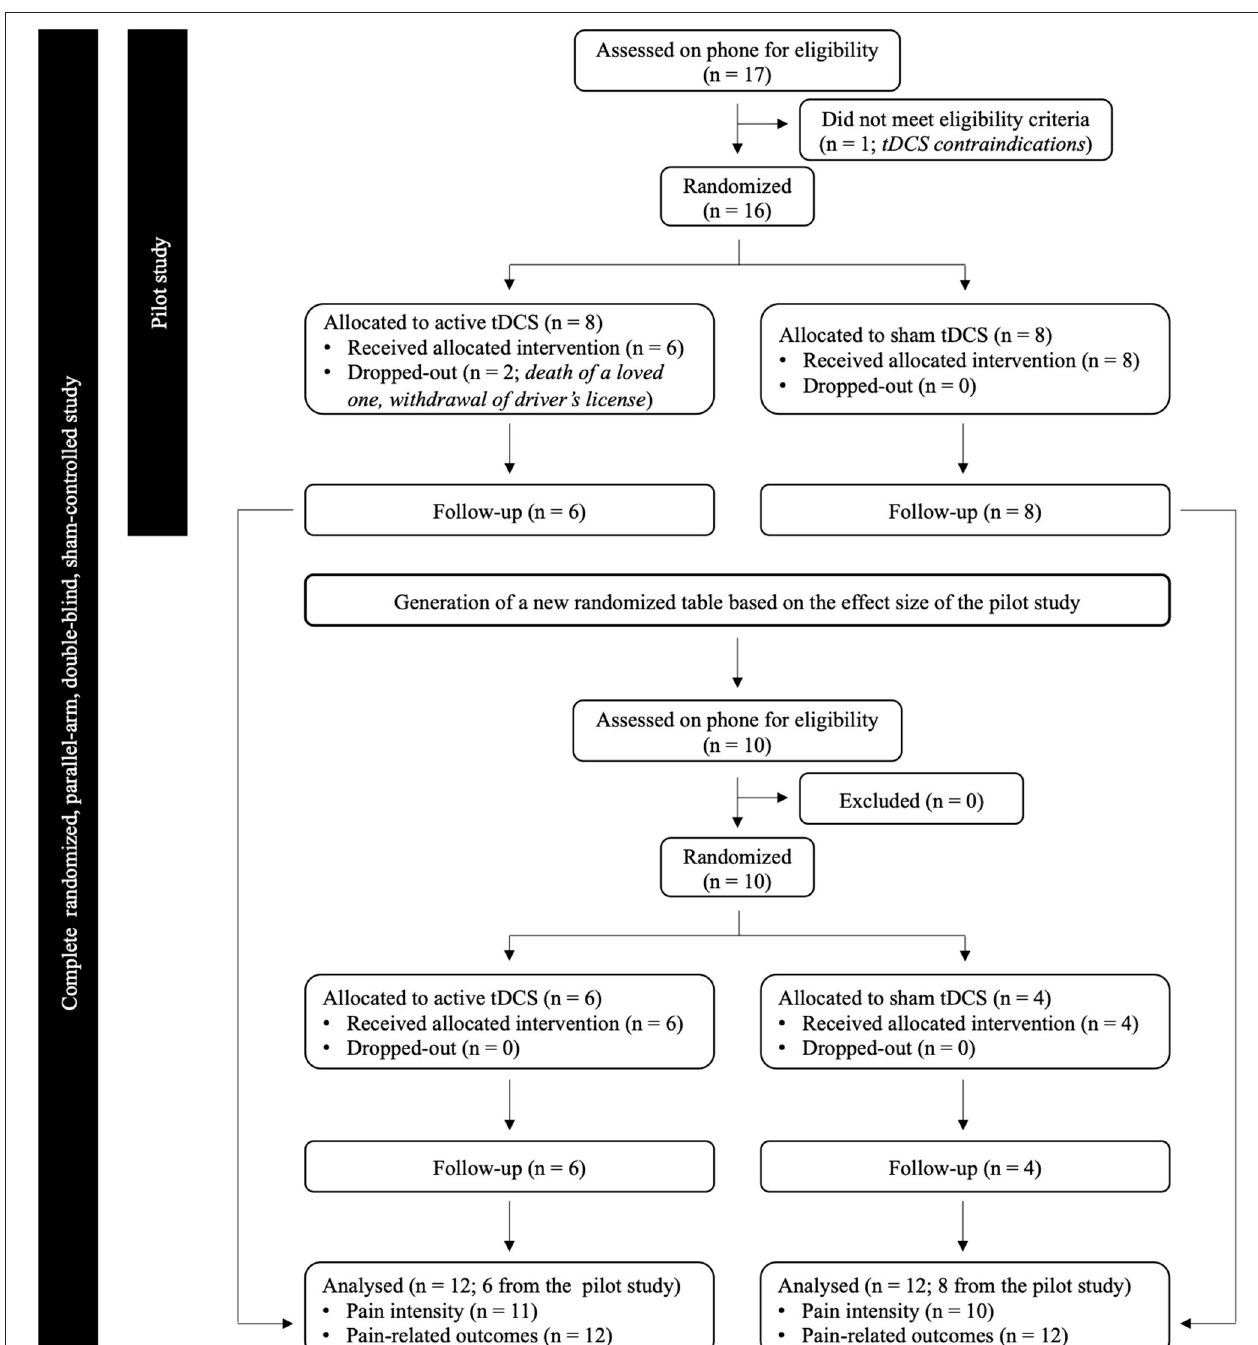
FIGURE 1 | Flowchart showing recruitment and progress through the study.